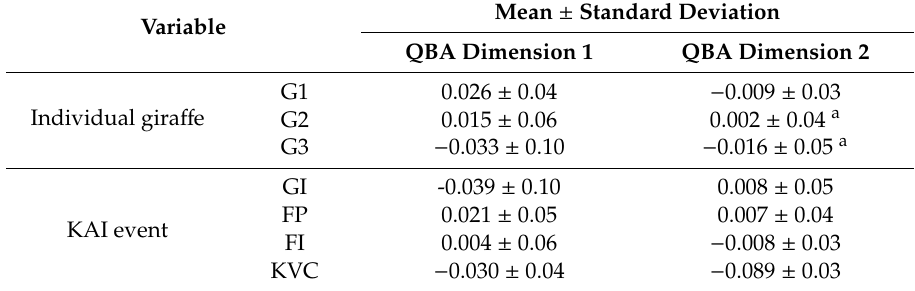
Table 5. Mean ± standard deviation values for individual giraffe scores and Keeper-animal interactions on Qualitative behaviour assessment (QBA) dimensions 1 and 2. G1 = giraffe 1, G2 = giraffe 2, G3 = giraffe 3, GI = giraffe initiated, FP = food provision, FI = food as incentive, KVC = keeper